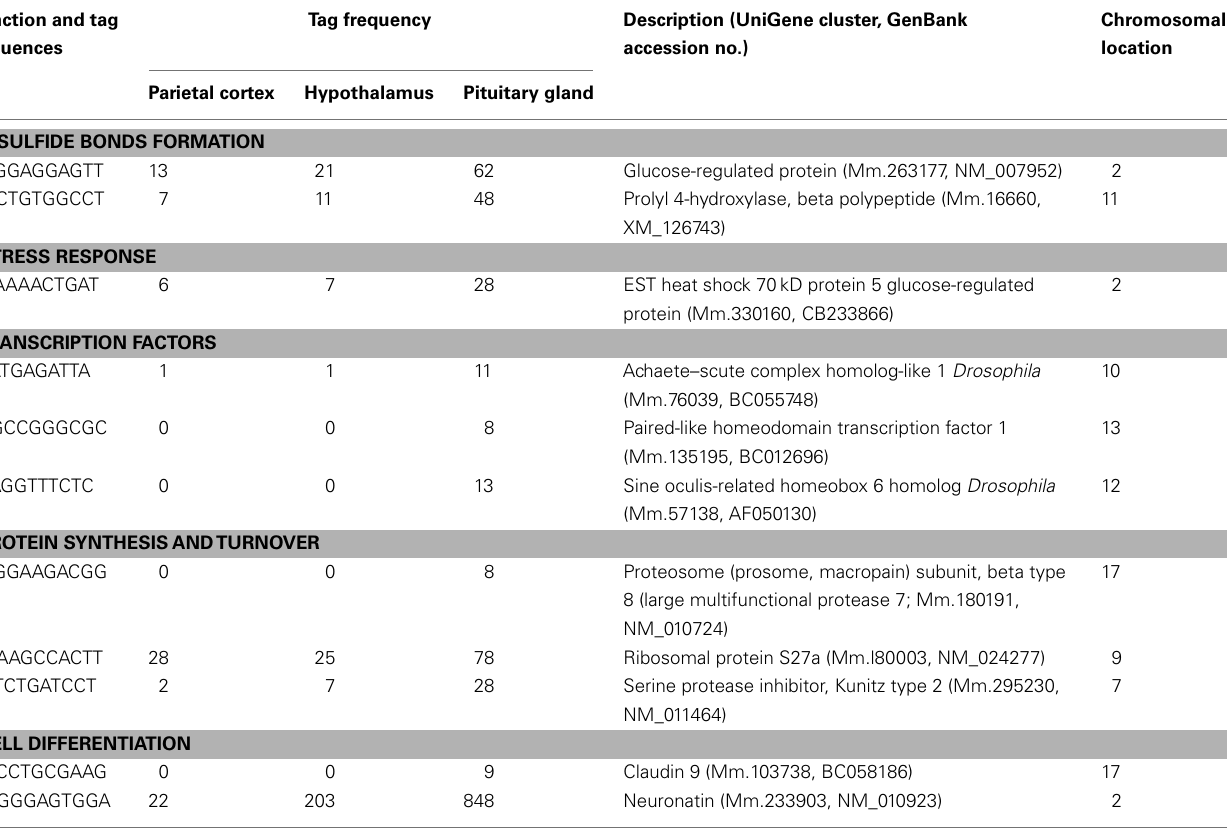
Table 5 | Components of the cell and organism defense, and gene expression preferentially expressed in pituitary gland.